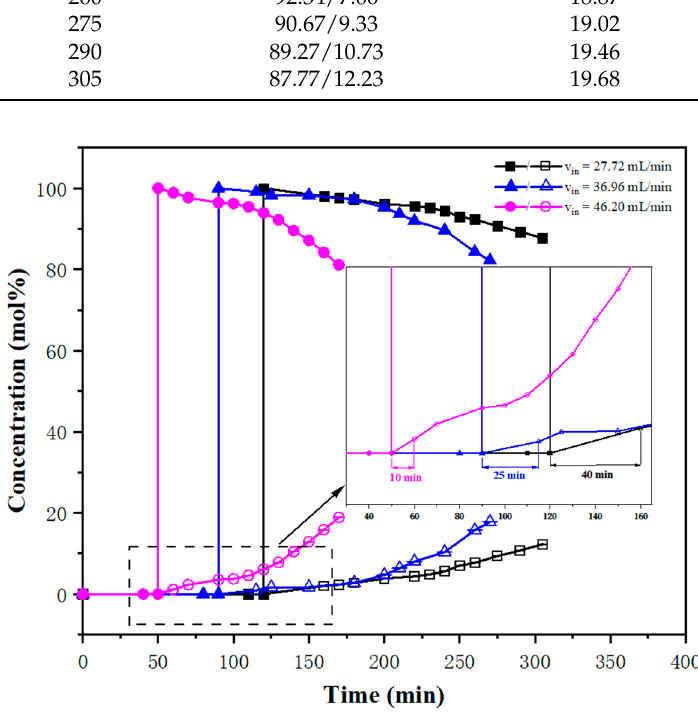
Figure 6. Breakthrough experimental results of the CH 4 /H 2 (34.22/65.78 mol%) mixture in the slurry with different solid contents of 20 wt%, 25 wt%, and 30 wt%, at 273.15 K, 2.00 MPa, and an inlet gas flow rate of 27.72 mL/min. (The solid curve in the figure is H 2 and the hollow curve is CH 4 ).